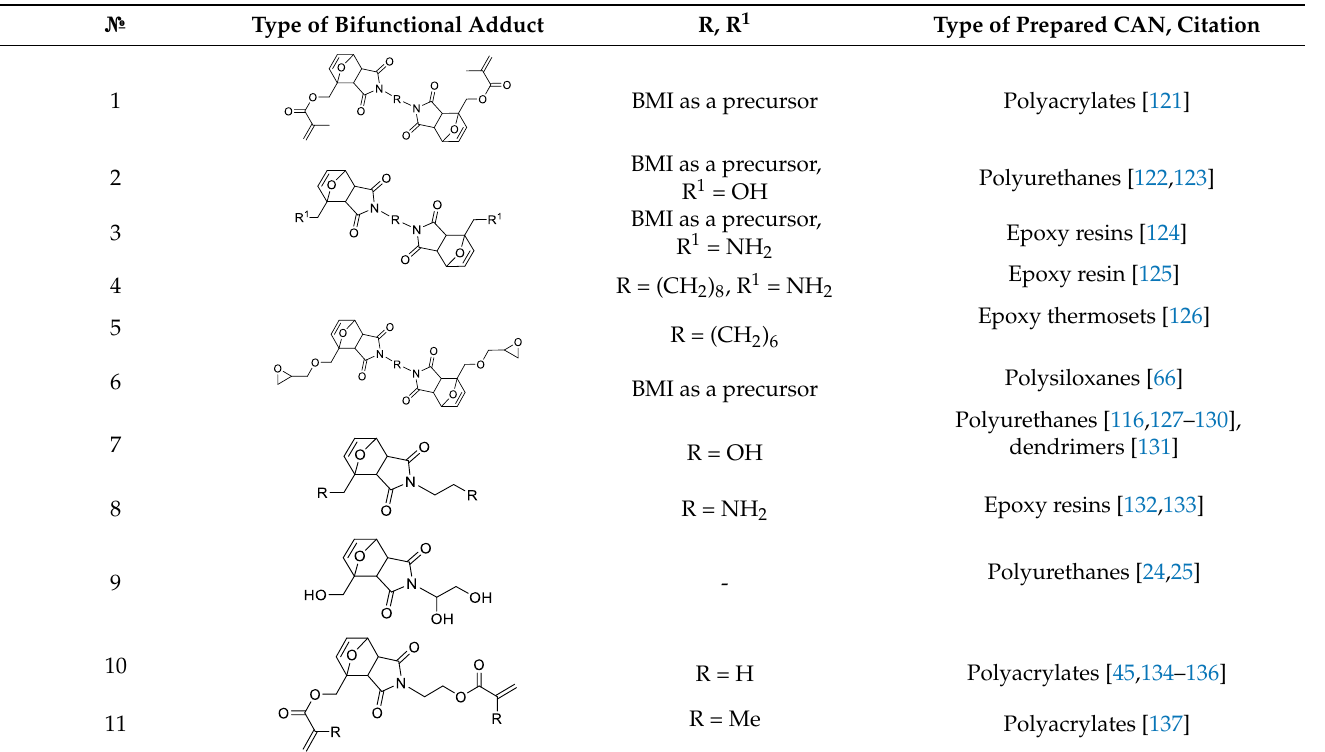
Table 5. Examples of the bifunctional fmDA adducts and types of prepared CANs.